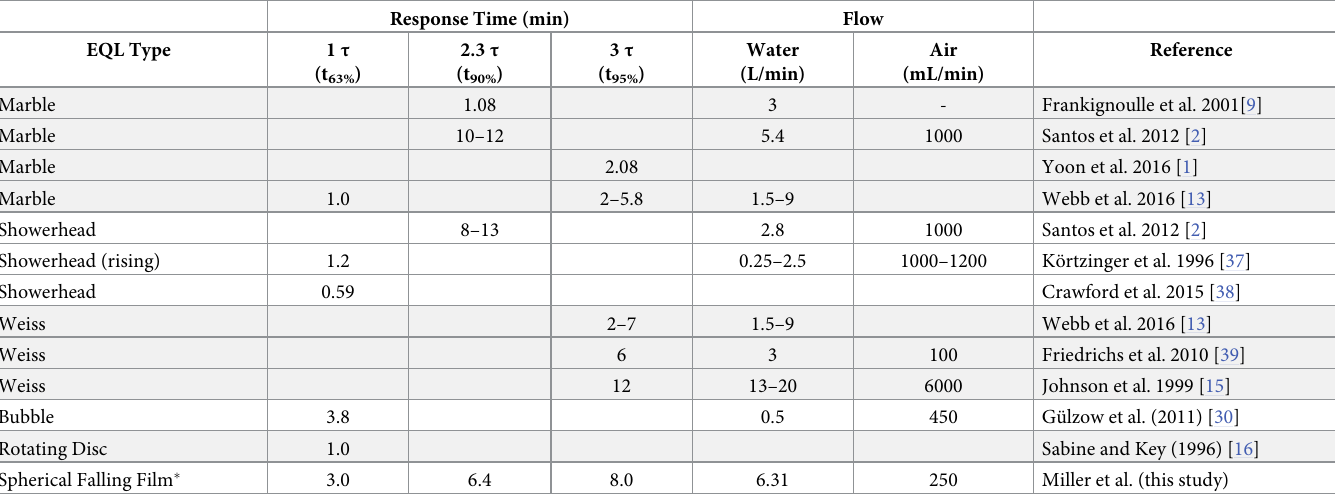
Table 3. Response times for measuring pCO 2 in water by active air-water equilibration (after Webb et al. [13]).